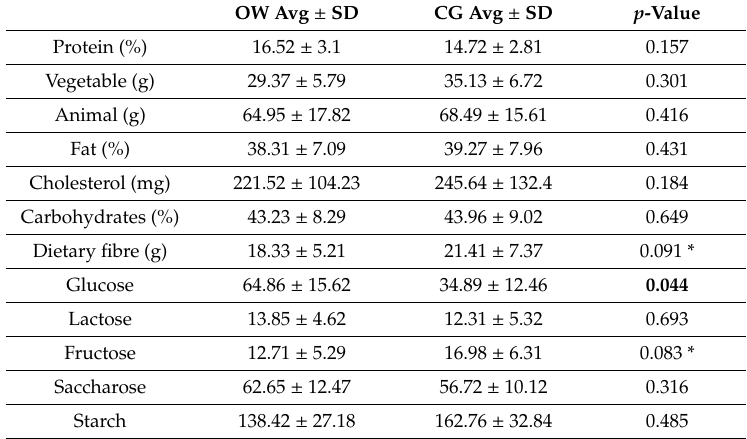
Table 1. Average consumption of nutrients in the diet in both